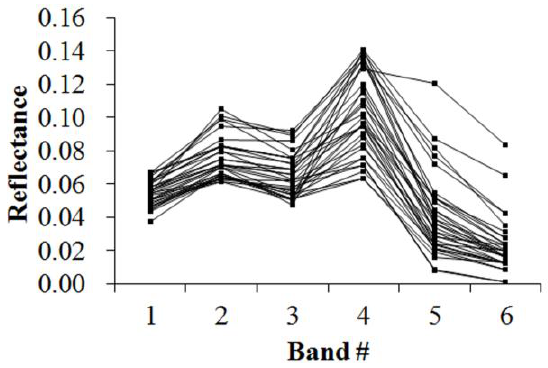
Figure 10. Spectral curves collected from samples used to determine Table 8.